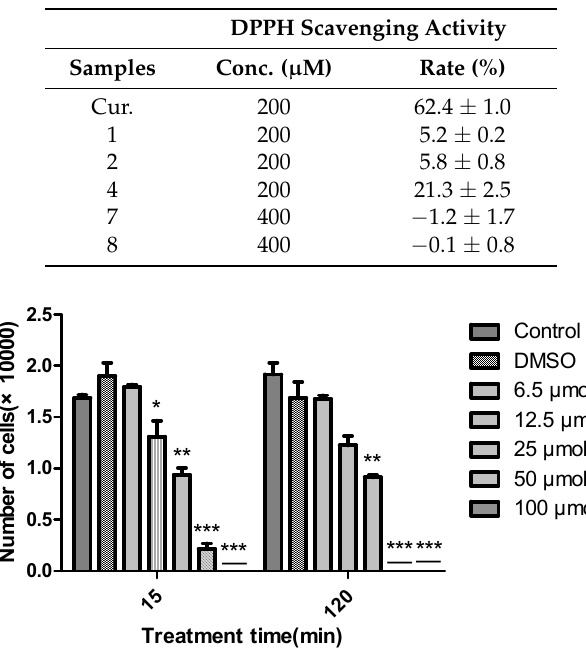
Figure 3. Algicidal effects of diorcinal ( 2 ) on the growth of Chattonella marina after 15 and 120 min of exposure. The data were expressed as the means ± SD from four individual experiments and were analyzed using a t -test to determine any significant differences. * p ≤ 0.05, ** p ≤ 0.01, *** p ≤ 0.001 compared to control group.